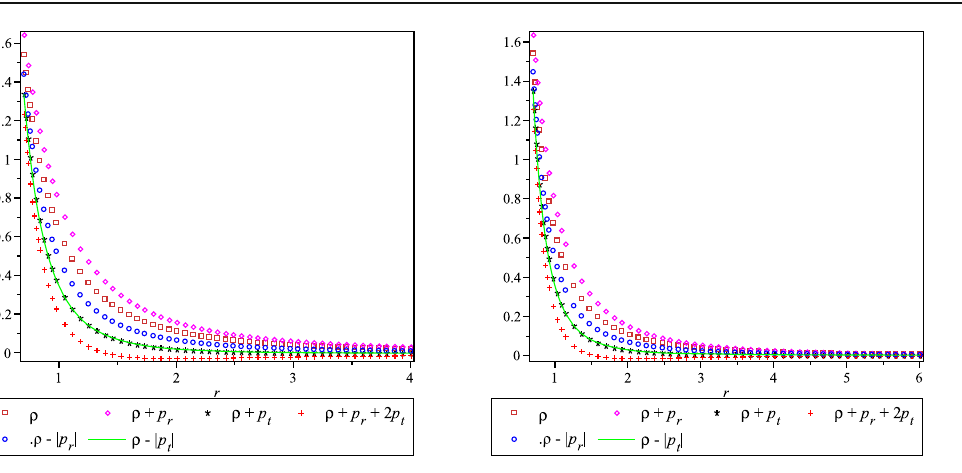
(b) This figure shows the behavior of all EC terms for Model-II in Subcase 4 ( ξ 2 = 0, α 2 < 0, α < 0). All ECs are found to be satisfied for every r > 0.